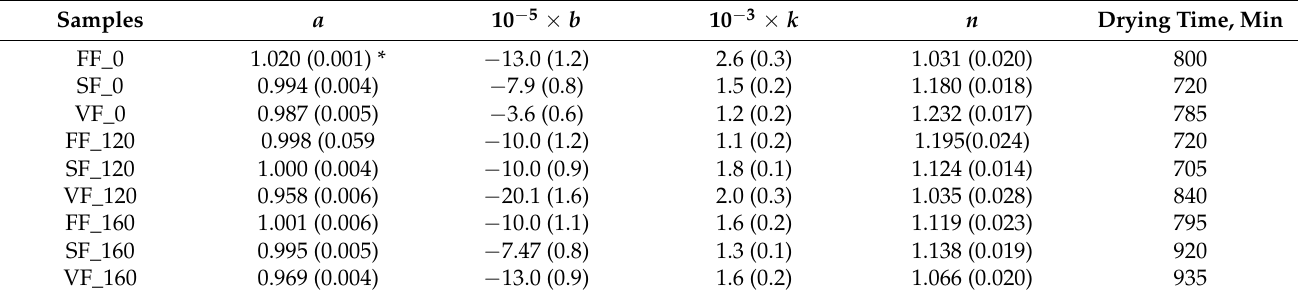
Table 5. Drying time and a , b , k , n constants of the Midilli et al. model for freeze-dried